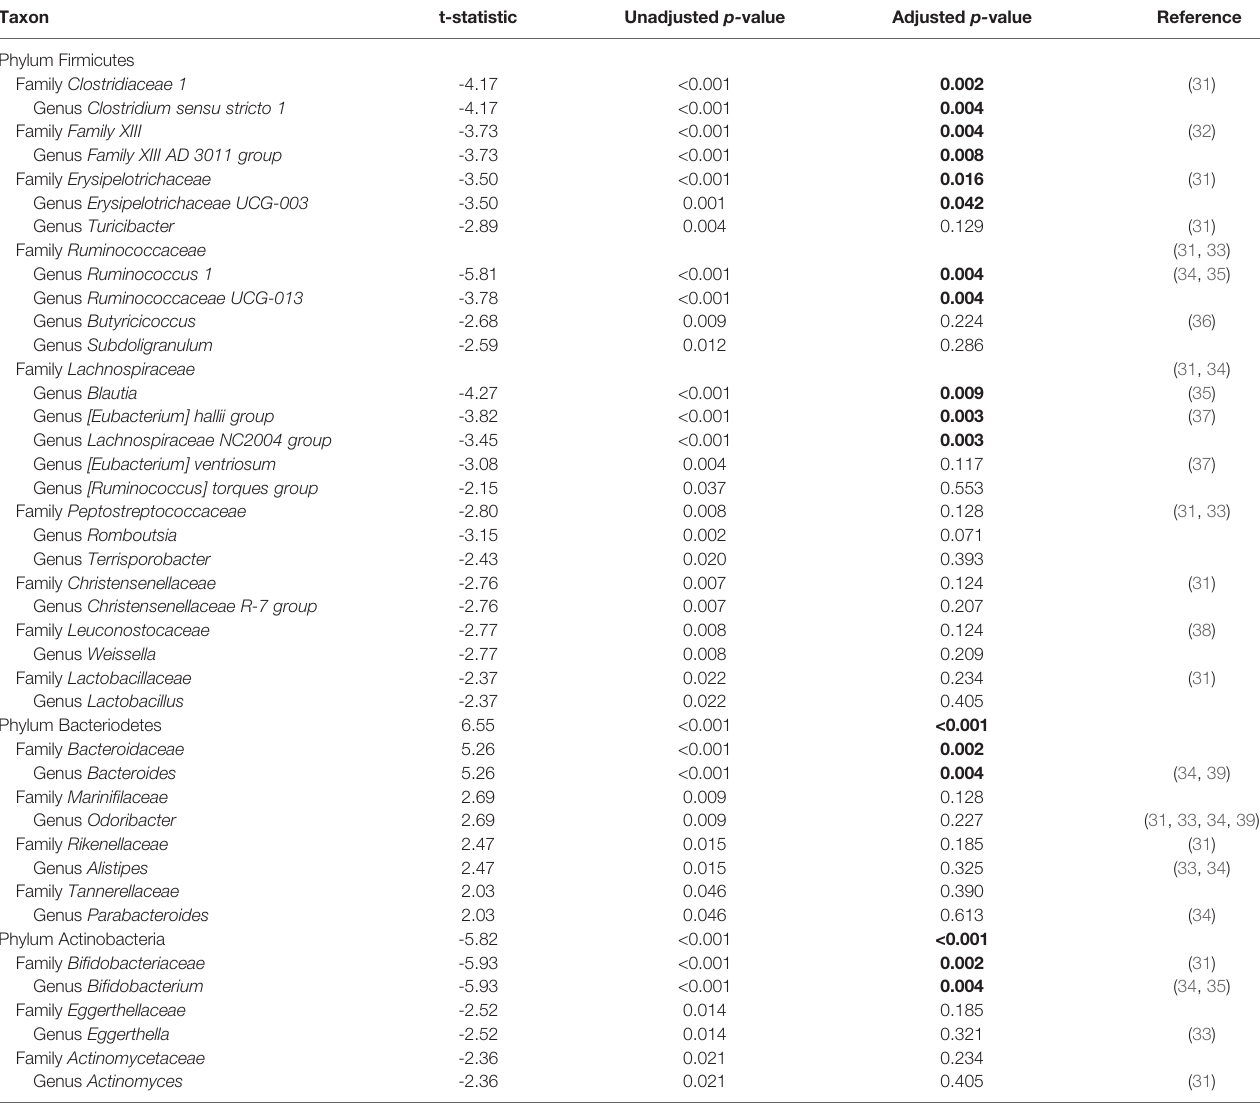
The change of column (log2 fold) represents the multiplicative change in taxa abundance from CRC to control. Negative numbers represent a trend of decreasing abundance in CRC group compared with control group. The data (p < 0.05) was provied as bold